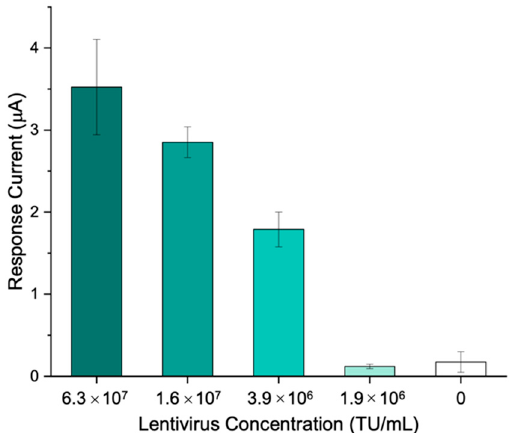
Figure 7. The electrochemical response of the designed immunosensor towards various whole SARS-CoV-2 replicating lentivirus concentrations.